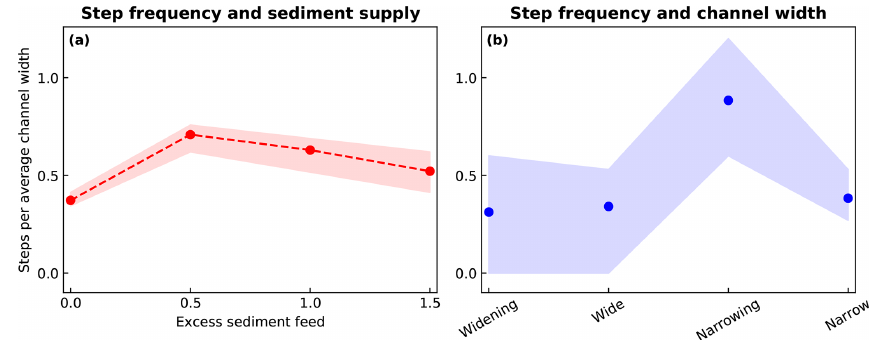
Figure 13. Step frequency (expressed as number of steps per number of channel widths) plotted as a function of (a) sediment supply and (b) longitudinal channel width variation. Markers represent mean values, and the shaded area is the 25th–75th percentiles. The excess sediment feed in panel (a) is expressed as the sediment feed divided by the transport